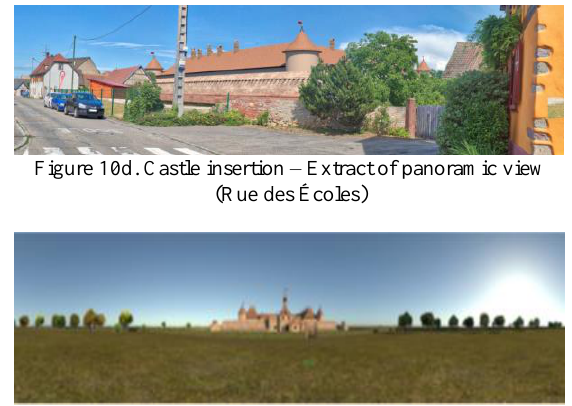
Figure 10e. Castle in historic environment.